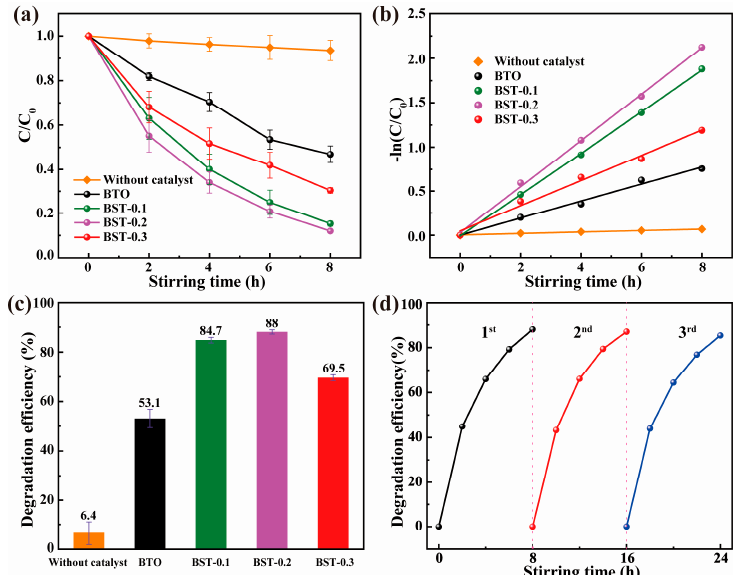
Figure 4. ( a ) Tribocatalytic degradation performance; ( b ) kinetic curves; ( c ) degradation efficiency of BST nanopowders for RhB solution; ( d ) degradation efficiency of BST ‐ 0.2 nanopowders after three